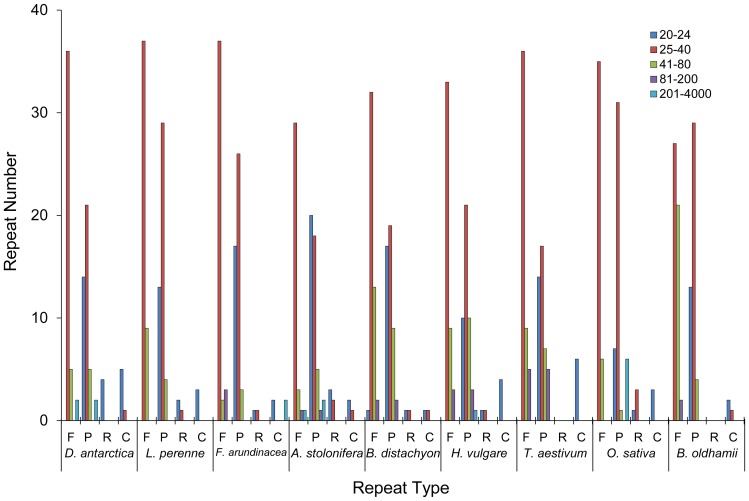
Repeat analysis in the Deschampsia antarctica chloroplast genome.Repeat sequences are compared among eight chloroplast genomes in the Poaceae family. To identify repeat sequences, the REPuter program was used. Repeats with length >20 bp and sequence identity e-value <10−3 were selected and categorized to four types based on their orientations (F: forward, P: palindromic, R: reverse).